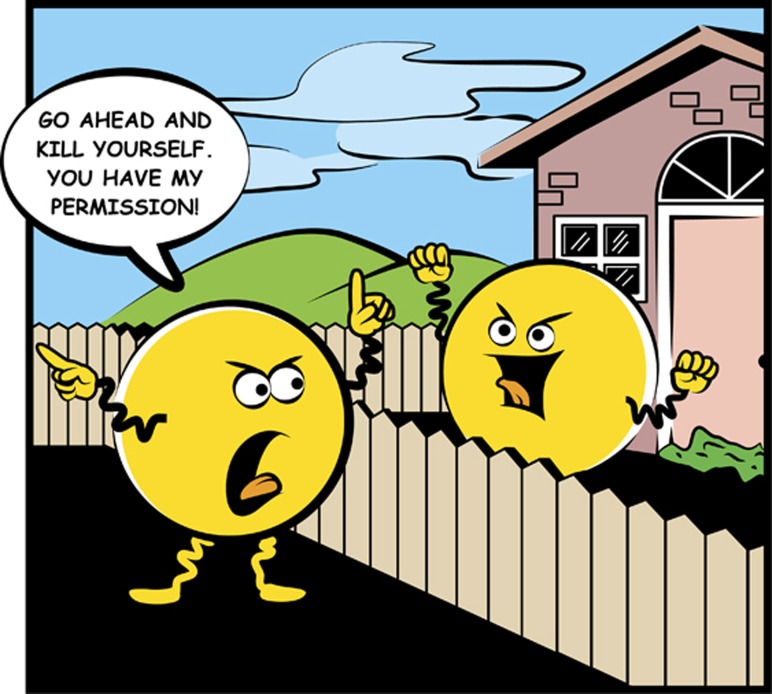
Cells use a variety of molecules, including fatty acids, to assist their neighbours with suicide